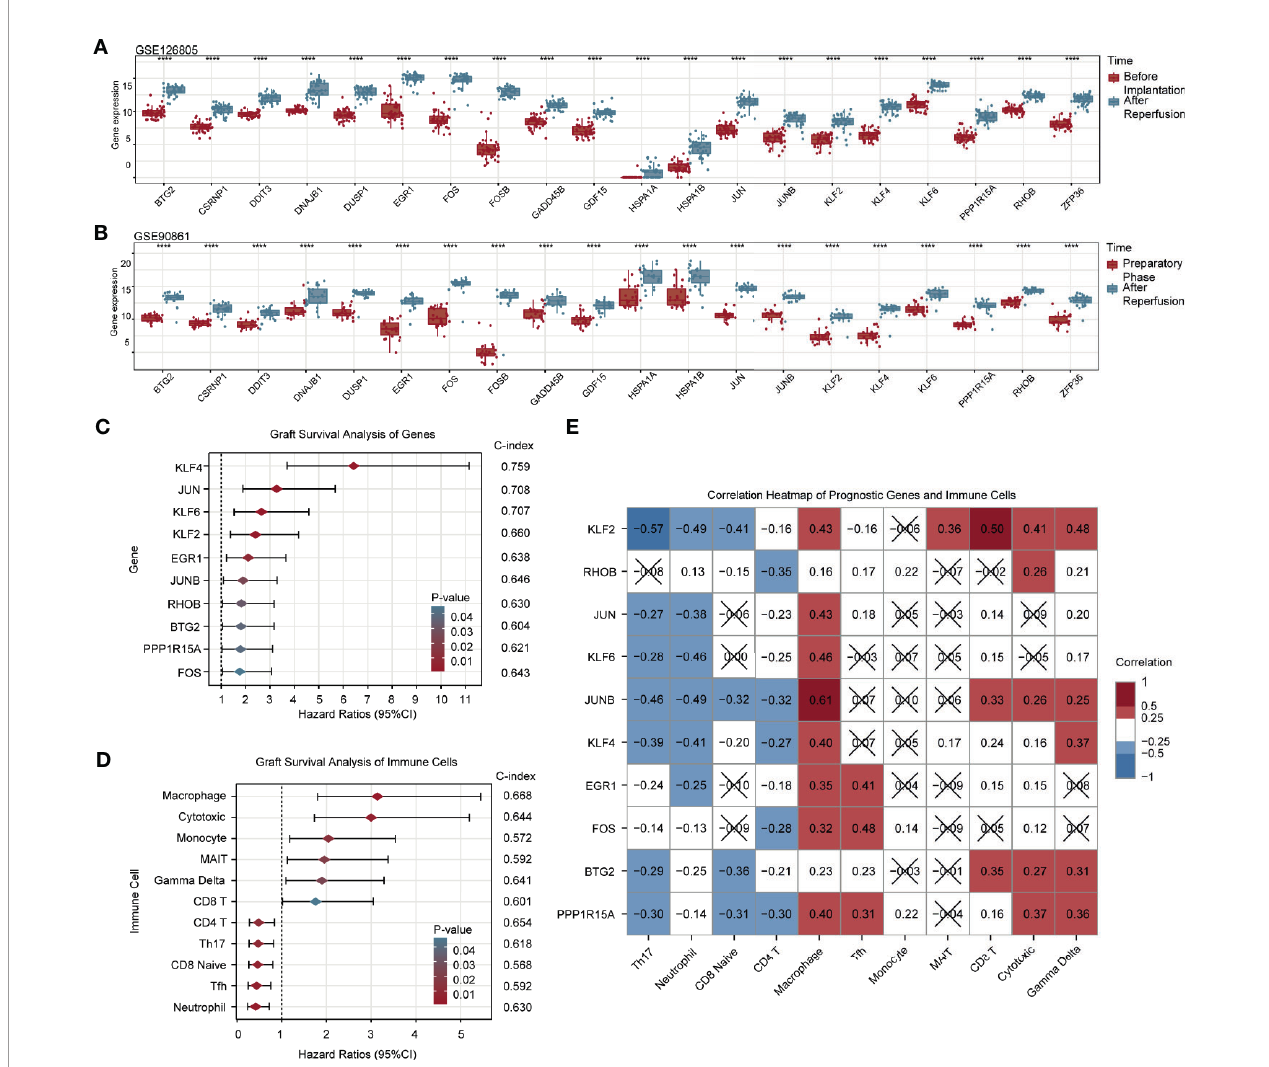
FIGURE 3 | Validation and graft survival analysis of DEGs. Box and scatter plots compare the expression levels of 20 upregulated RIRI-associated DEGs (A, B) . Forest plots show hazard ratios and their 95% con fi dence intervals of 10 prognostic DEGs (C) and immune cells (D) . C-indexes are also displayed on the right side of both pictures. (E) Correlation heat map for gene expression and immune cell in fi ltration; red and blue represent positive and negative correlations, respectively. No statistically signi fi cant correlations ( p > 0.05) are denoted by black